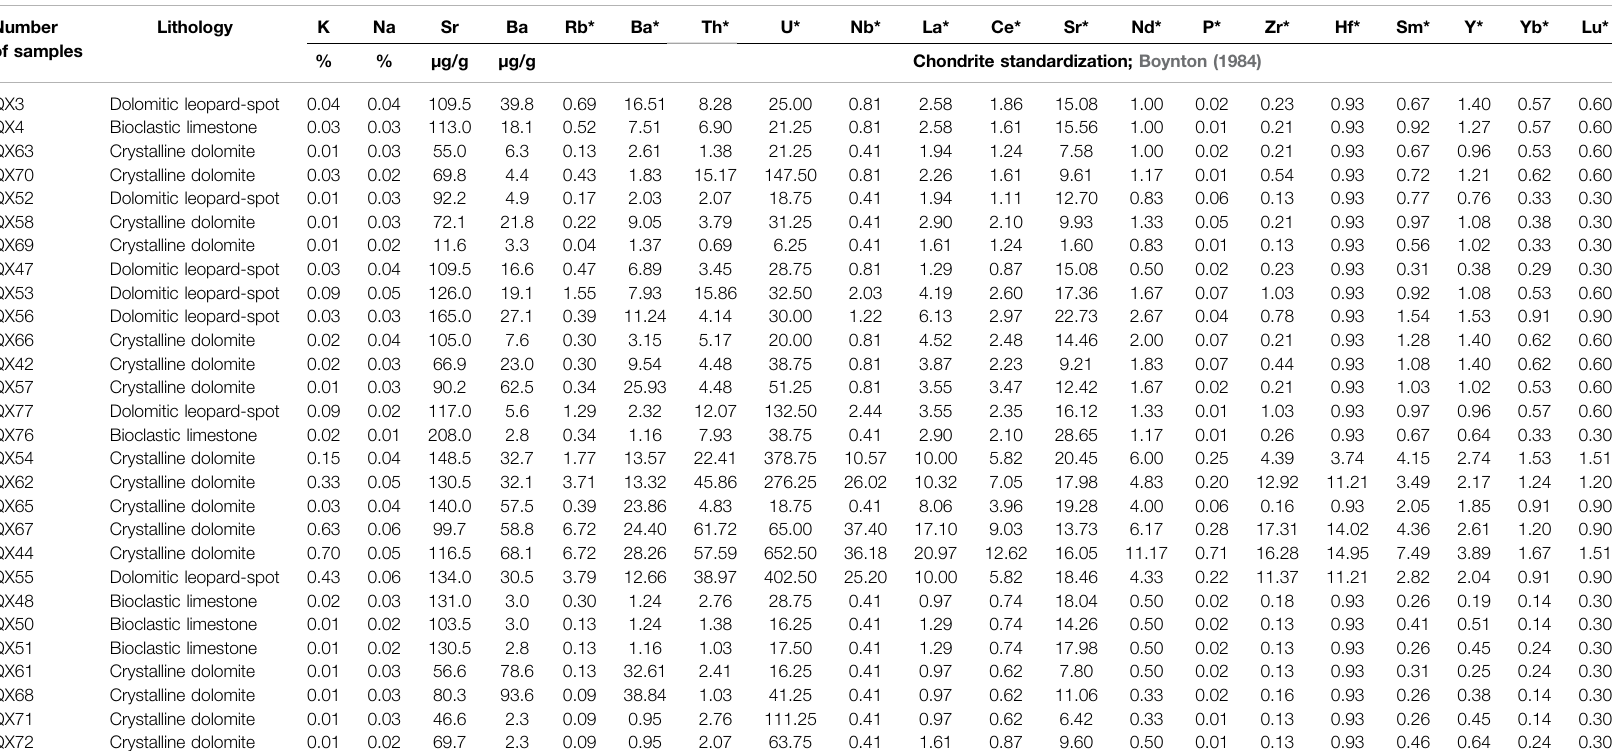
TABLE 2 | Carbonate microelement test results of Qixia Formation in the study area (chondrite standardization). Number of